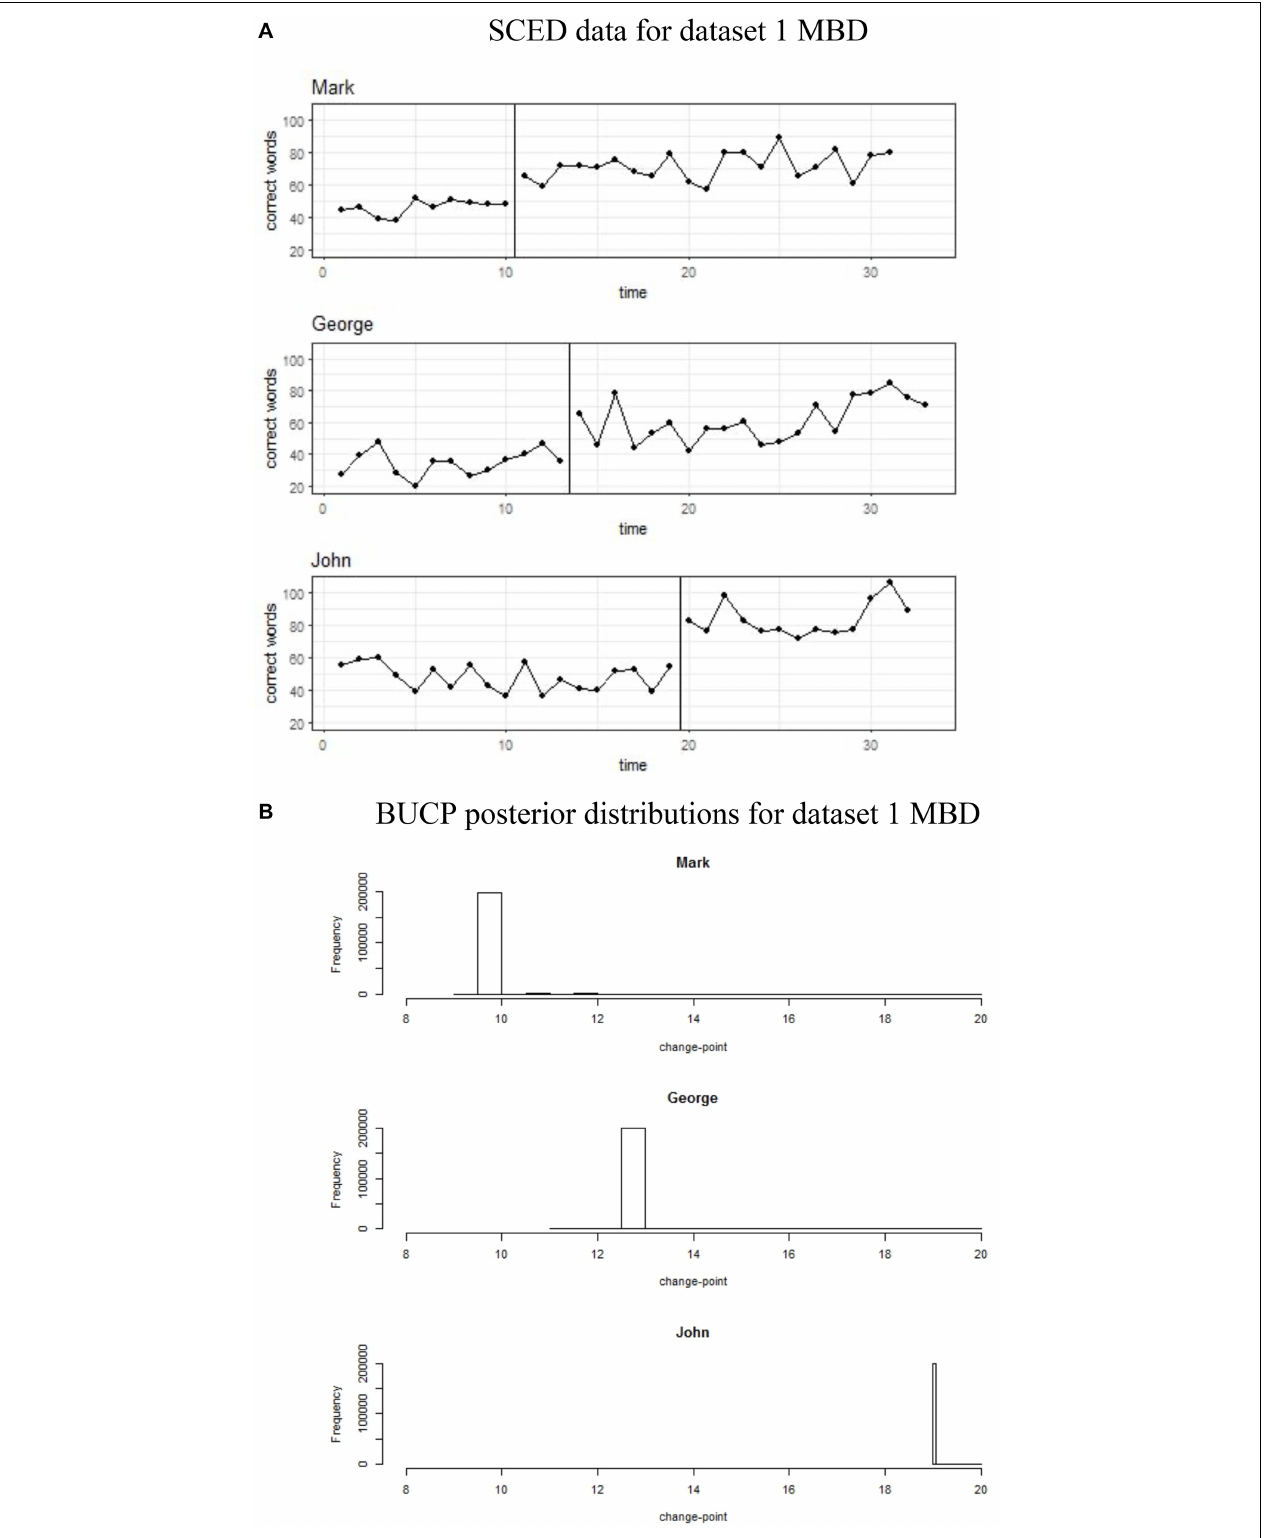
FIGURE 2 | (A,B) Single case experimental design (SCED) raw data for MBD dataset 1 paired with the posterior distribution for change-points obtained with Bayesian unknown change-point (BUCP).